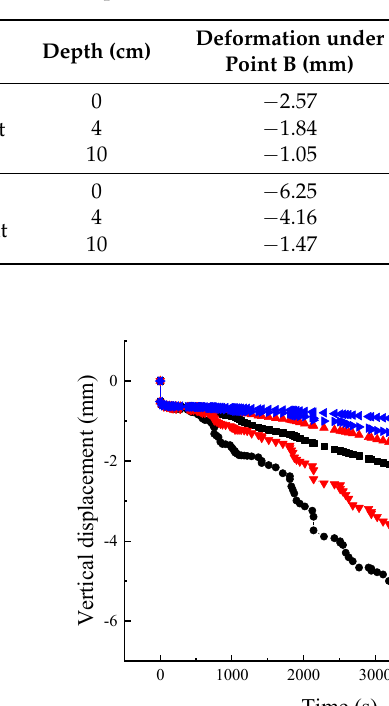
− 0.441 Table 15. Material parameters of middle surface layer of conventional asphalt pavement.